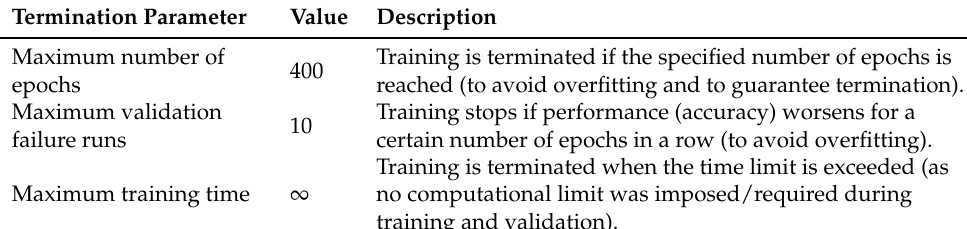
Table 6. Training termination parameters to end training after requirements have been met.